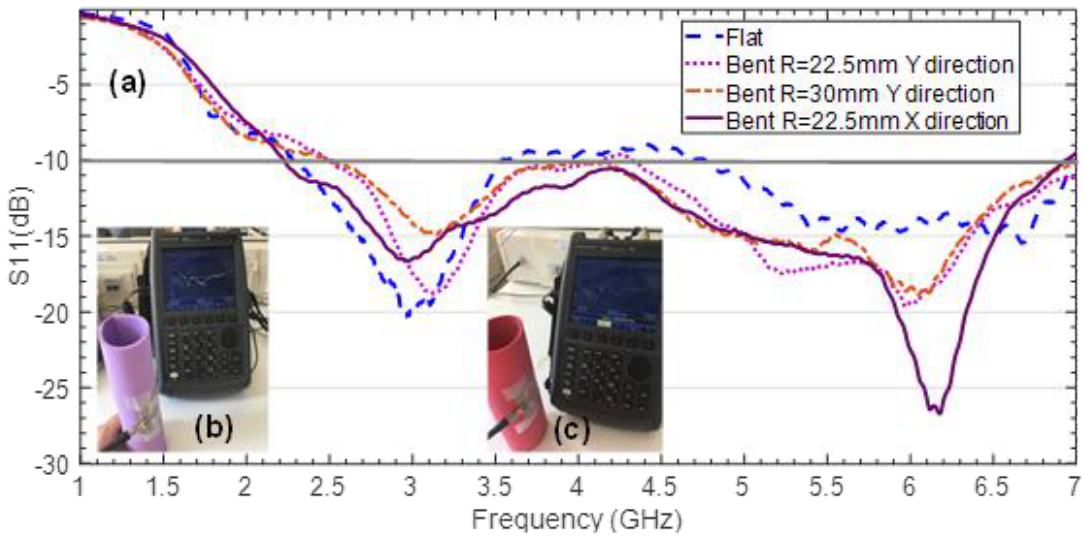
Figure 8. Measurement results concerning the return losses for the CPW-fed slot monopole antenna on ENrG’s Thin E-Strate under flat and bent conditions ( a ). Measurement set-up using a mauve foam cylinder of radius R = 22.5 mm ( b ) and red foam cylinder of radius R = 30 mm ( c ).